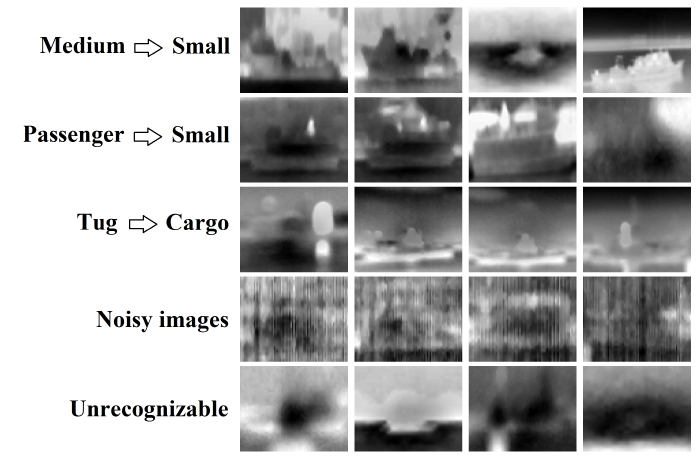
Figure 8. Some misclassified VAIS test samples using our approach (CONV_3 features, large network). The first row, for example, corresponds to some test samples labeled as Medium and misclassified by our algorithm as Small .